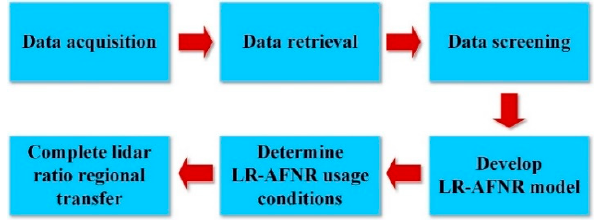
Figure 2. Flowchart of the lidar ratio regional transfer method. The flowchart consists of six steps: data acquisition, data retrieval, data screening, developing the LR-AFNR model, determining the conditions for using the LR-AFNR, and completing the lidar ratio regional transfer.